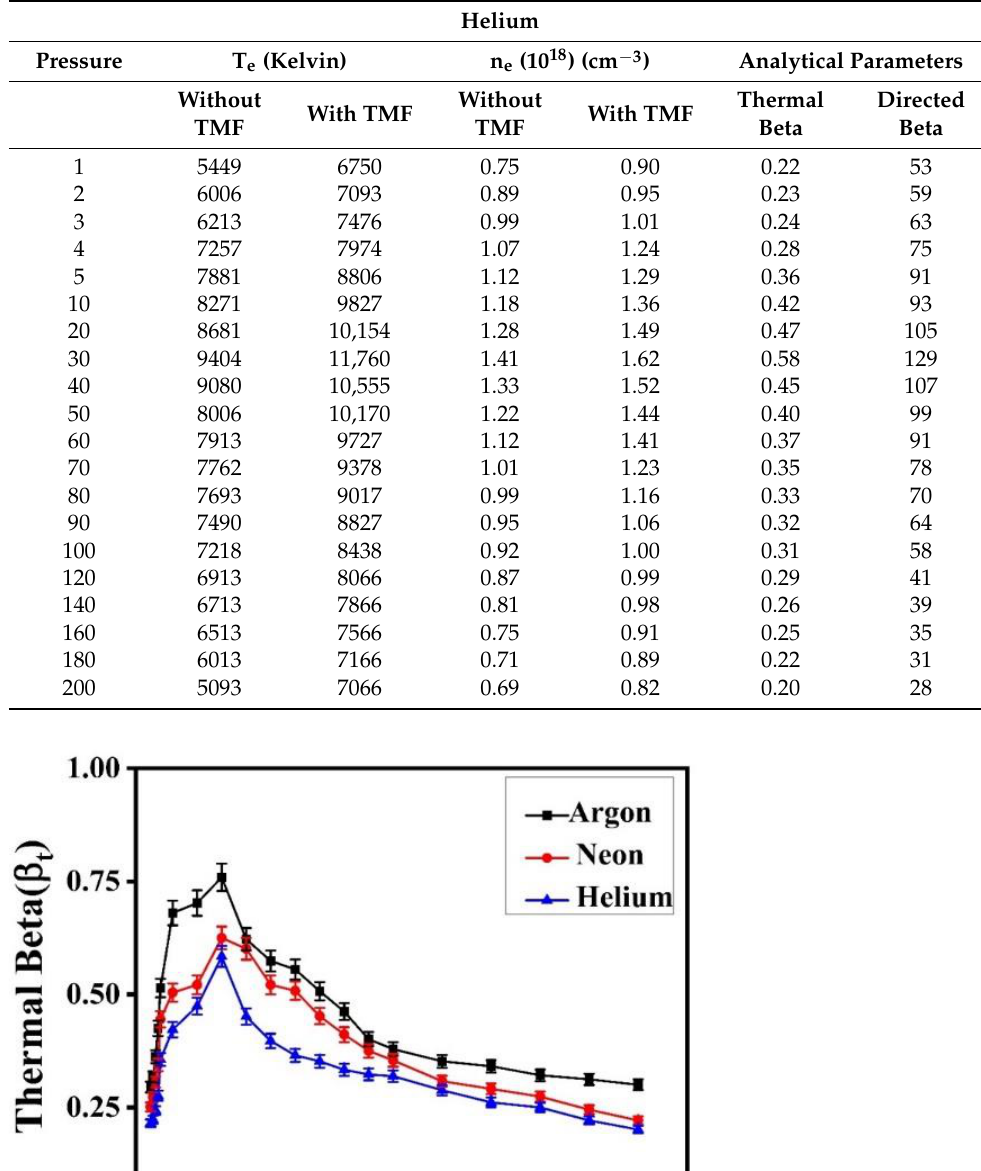
Table 4. Evaluated T e , n e , β t , and β d values for laser-irradiated Cu-alloy plasma at various He pressures in the presence and absence of TMF.